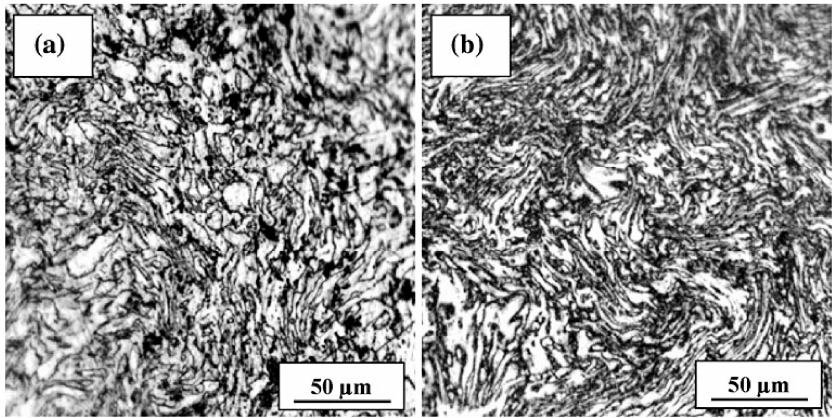
Figure 22. Optical image of ( a ) AZ31 and ( b ) 1 vol % CNT-AZ31 nanocomposites fabricated through